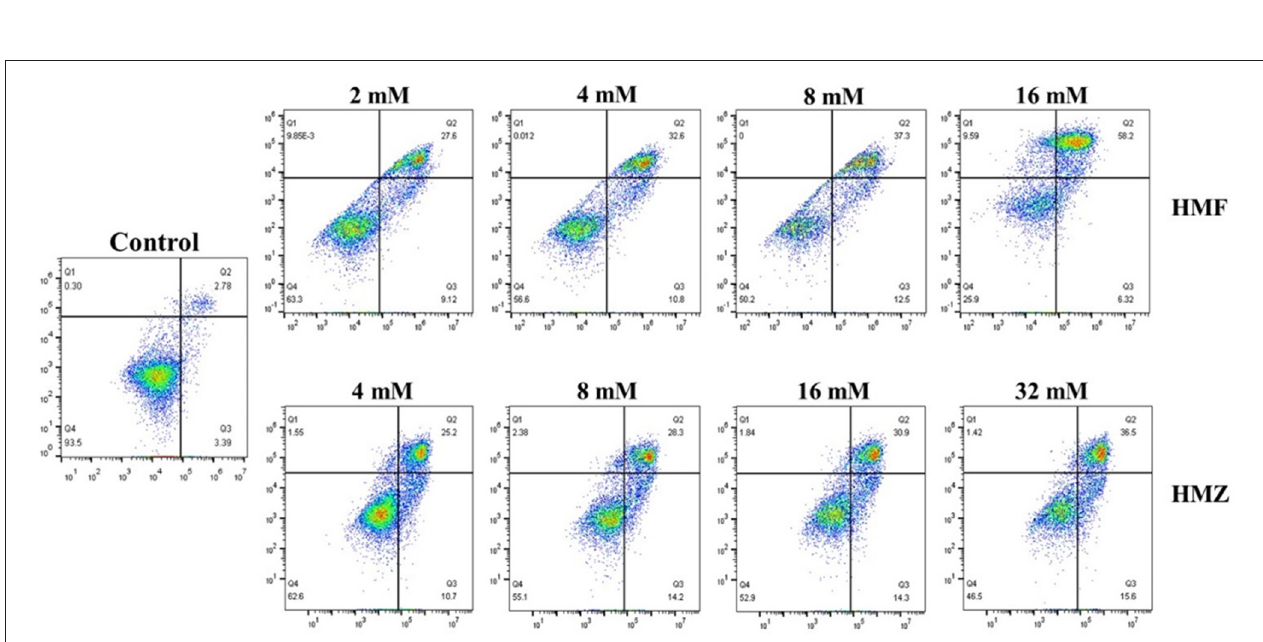
FIGURE 5 | Effects of HMF and HMZ at different concentrations on apoptosis in Caco-2 cells after